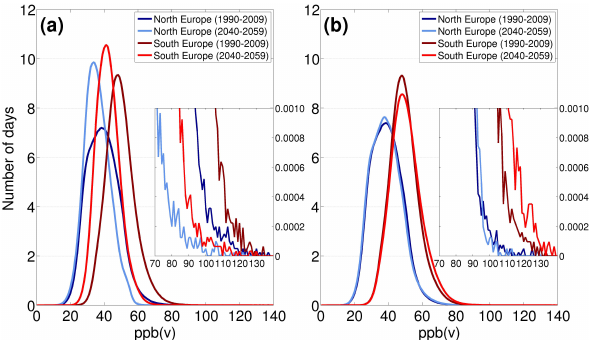
Fig. 2. Frequency distributions of daily max O 3 concentrations in North and South Europe during the periods 1990–2009 and 2040– 2059 in the Increasing boundary case simulation (a) and Climate sensitivity case 1 (b) . The distributions show the number of days per year one arbitrary model grid point in northern and southern Europe experiences daily maximum O 3 concentrations between X and X +1 ppb(v) during the respective 20-yr